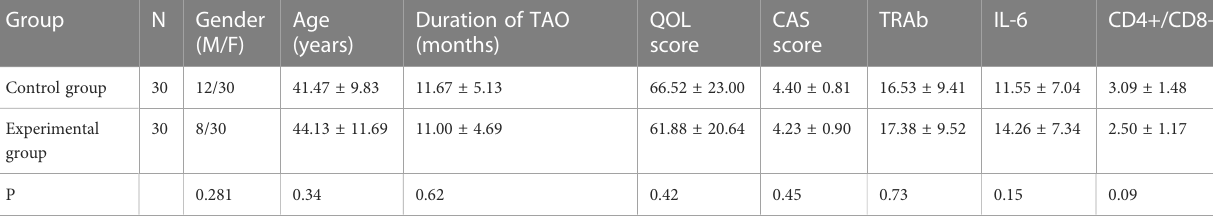
TABLE 1 Comparison between the general information data of the two groups.